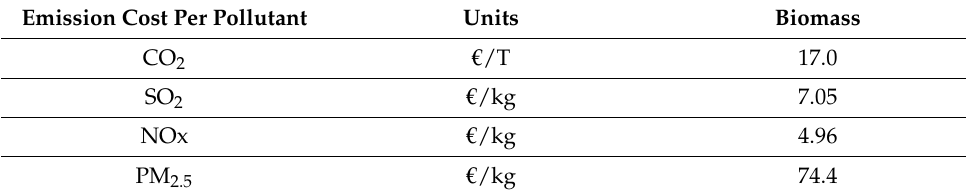
Table A5. Social cost